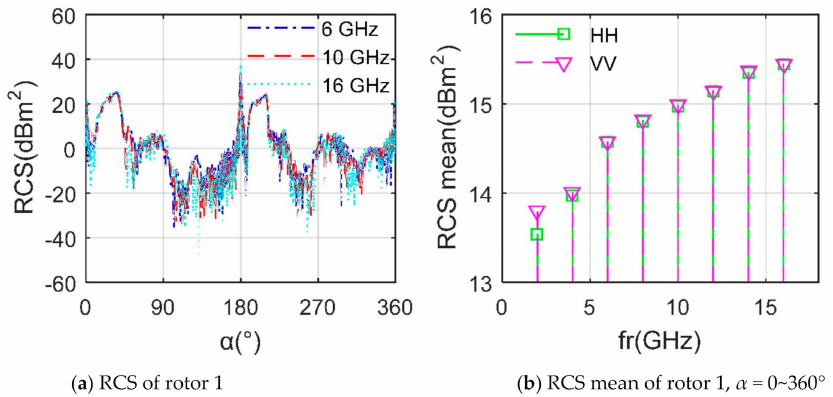
Figure 6. RCS curve of rotor 1, t = 0 s, A c1 = 0 ◦ , f r represents the frequency of the radar wave, HH means horizontal polarization, VV means vertical polarization. ( a ) RCS curves of rotor 1. ( b ) RCS mean of rotor 1, α = 0~360 ◦ .